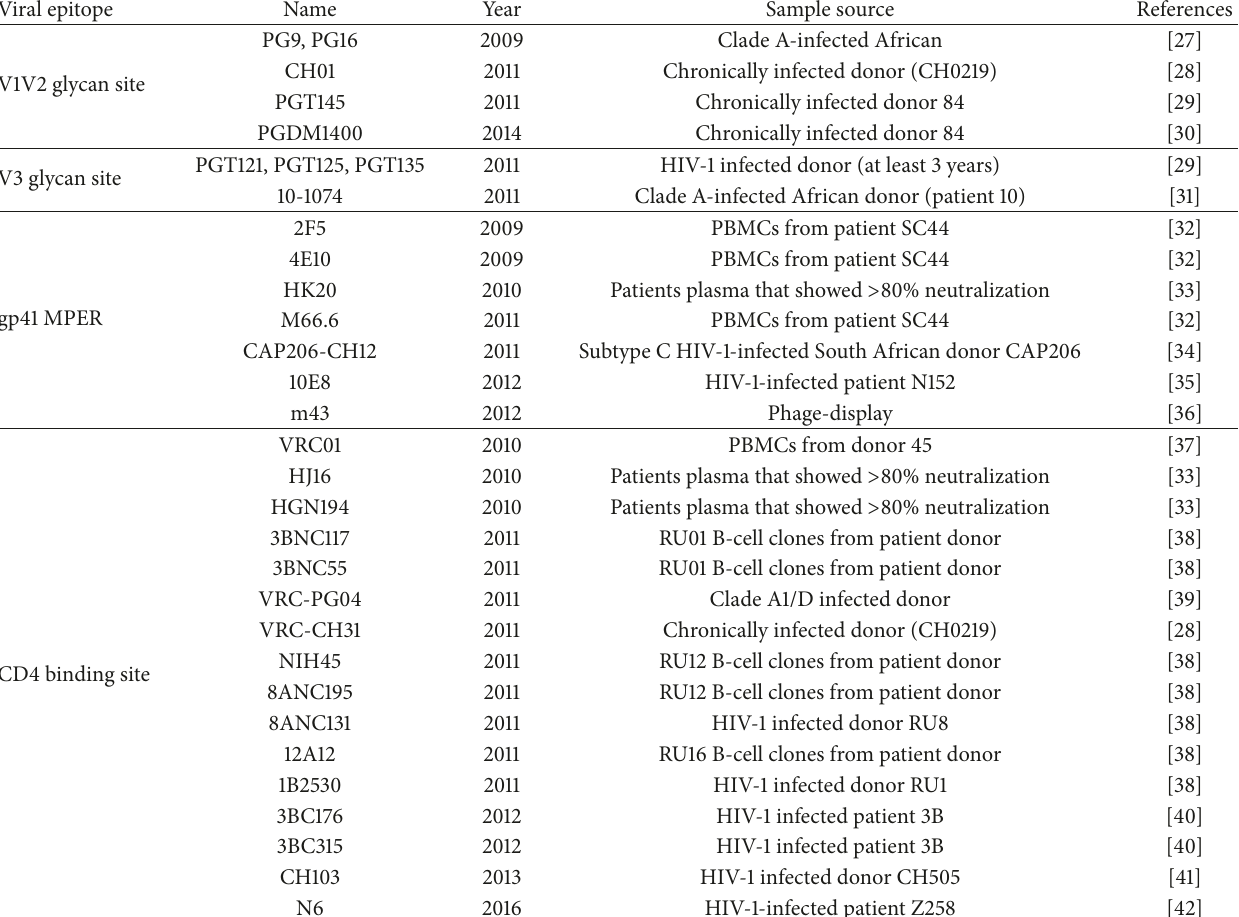
Table 1: Anti-HIV broad neutralizing antibodies (bnAbs) in the past 10 years.